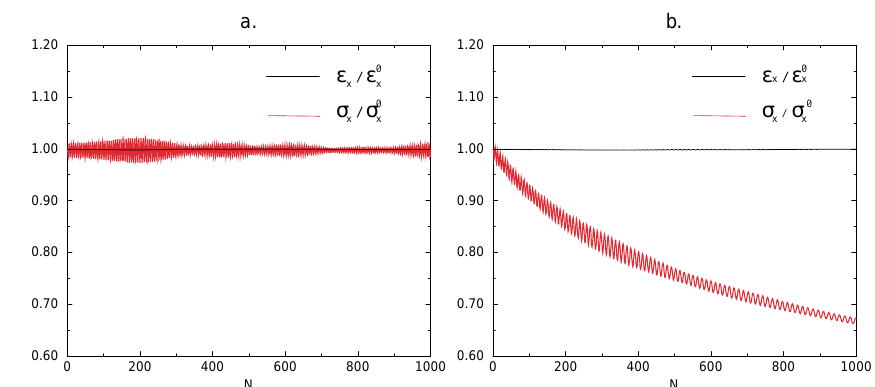
FIG. 2. (Color) The rms beam size s x and normalized rms x emittance e x vs stage number N . The parameters used were g p (cid:1) 100 , (cid:2) g (cid:1) 0.01 , and s (cid:1) 2.2 nm, r (cid:1) 0.5 mm, s (cid:1) 0.01 . (a) No acceleration and no dislocations, (b) no drift (cid:1) 17 cm, e 0 dg dC s x dislocations.